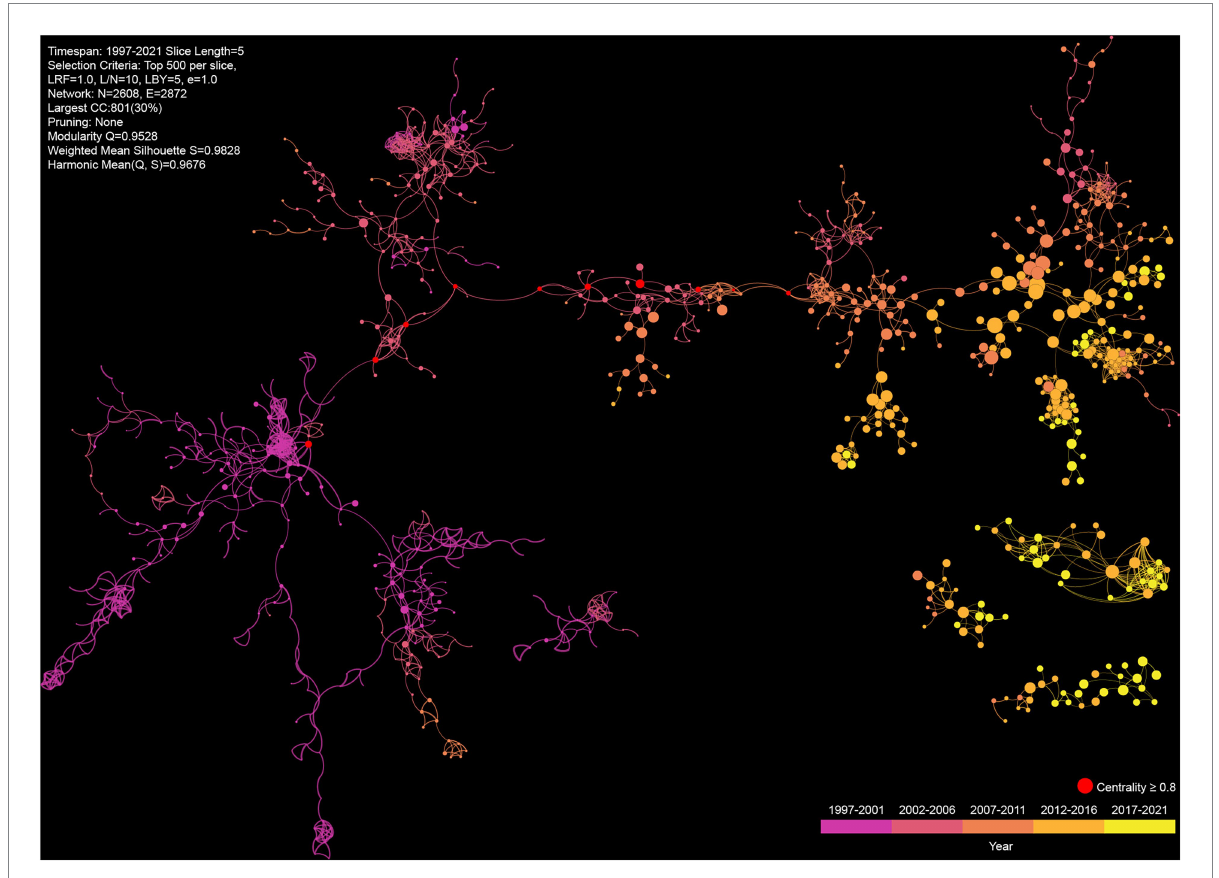
FIGURE 4 The top 5 largest components of co-citation network on the gut microbiome and disease between 1997 and 2021. Each node represents a cited article, and the size reflects the number of co-citations, and the edges denote the co-cited relationships among